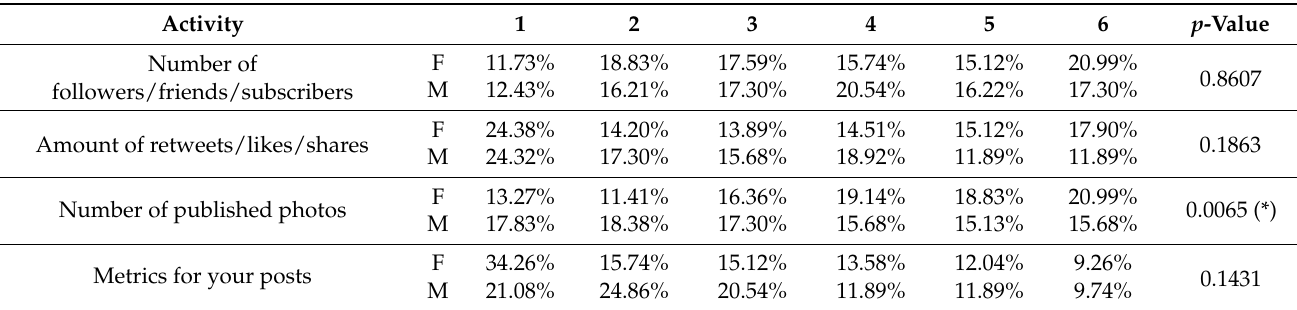
Table 9. Degree of motivation generated by the knowledge of the impact according to the type of activity carried out on the